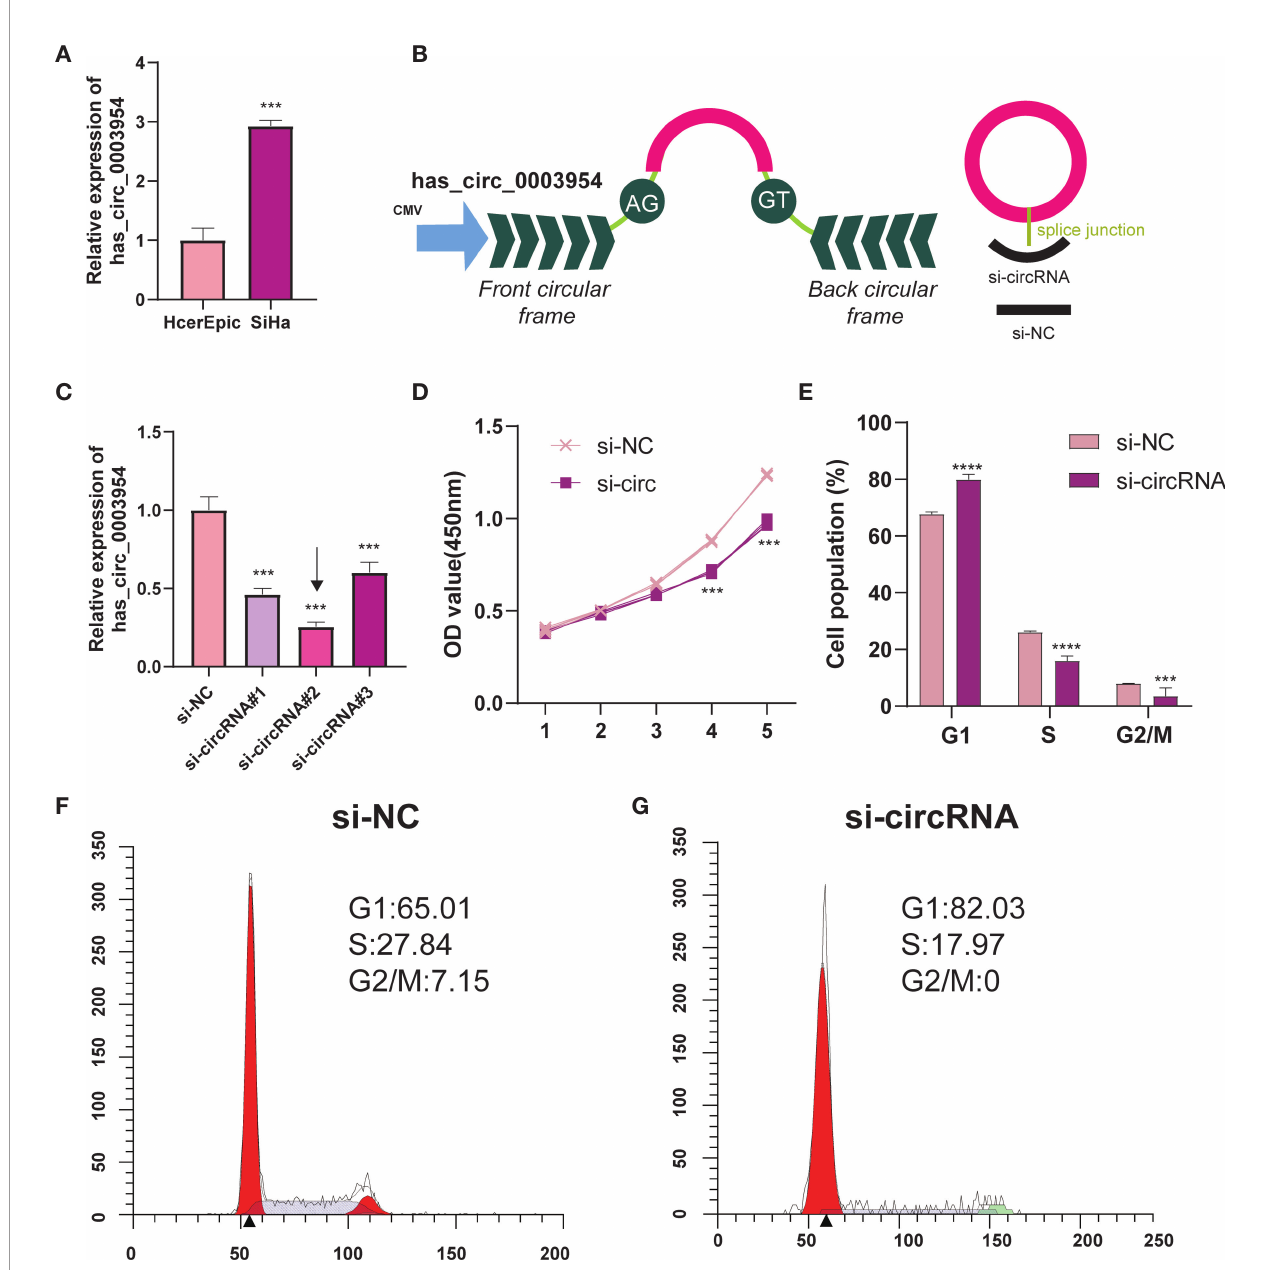
FIGURE 10 | Silencing of hsa_circ_0003954 effects cell proliferation progression and cell cycle in SiHa cells. (A) Relative expression of hsa_circ_0003954 in cell lines was determined by qRT-PCR. (B) The schematic illustration of hsa_circ_0003954 expression vector and siRNAs. (C) qRT-PCR analysis of hsa_circ_0003954 expression in SiHa cells transfected with si-circ or si-NC. (D) The growth curves of cells transfected with si-circ or si-NC were evaluated by CCK-8 assays. (E – G) The cell cycle progression was analyzed by fl ow cytometry after transfected with si-circ or si-NC. *** p < 0.001, **** p <